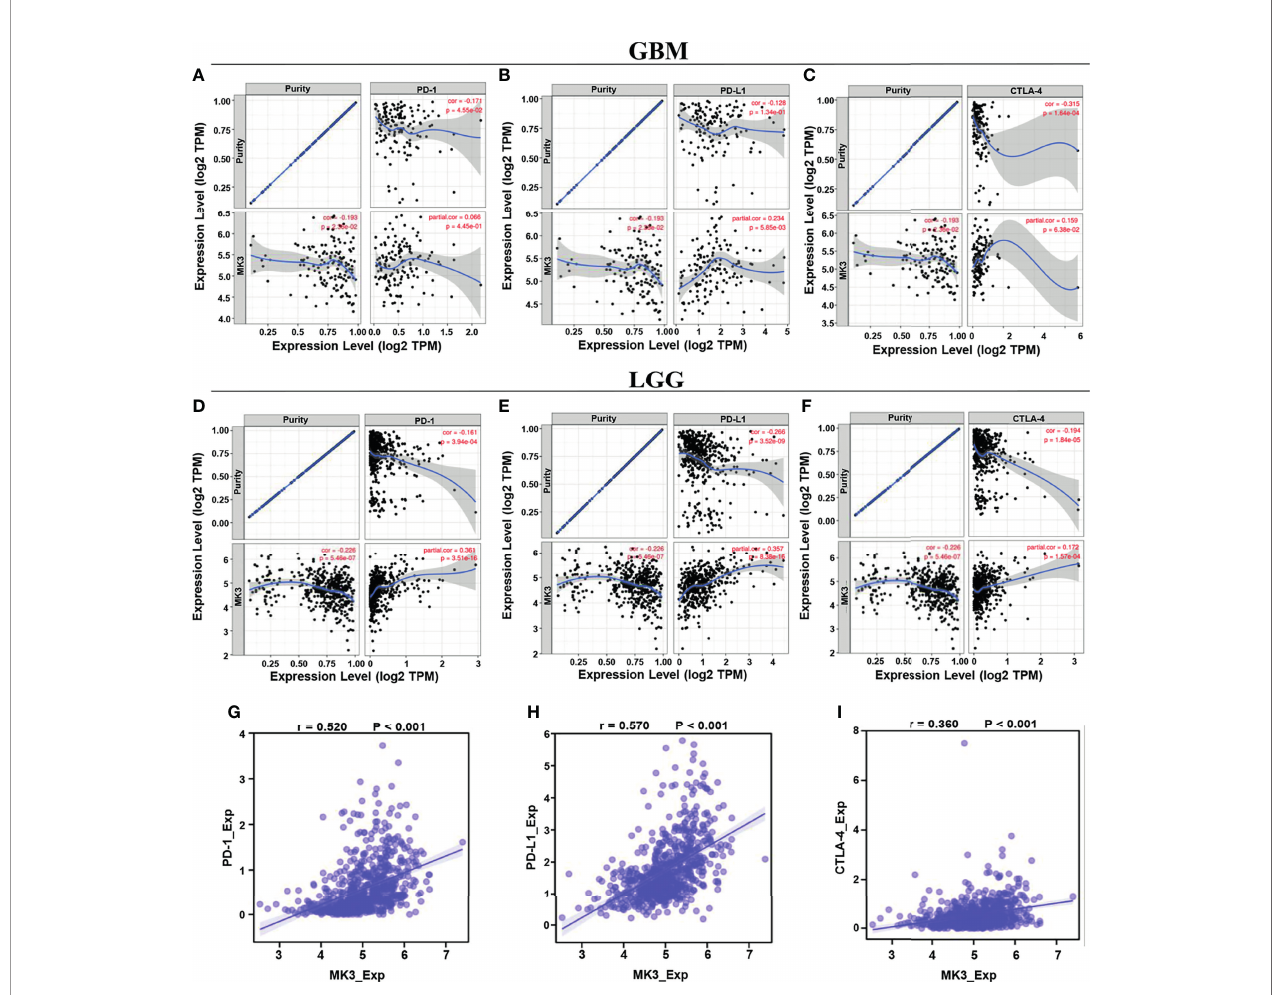
FIGURE 8 | Correlation of MK3 expression with PD-1 , PD-L1 , and CTLA-4 in glioma. (A – C) Correlation of MK3 expression with PD-1 (A) , PD-L1 (B) , and CTLA-4 (C) in GBM adjusted by tumor purity using TIMER. (D – F) Correlation of MK3 expression with PD-1 (D) , PD-L1 (E) , and CTLA-4 (F) in LGG adjusted by tumor purity using TIMER. (G – I) The expression correlation of MK3 with PD-1 (G) , PD-L1 (H) , and CTLA-4 (I) in GBM and LGG samples from TCGA dataset. GBM, glioblastoma; TIMER, Tumor IMmune Estimation Resource; LGG, low-grade glioma; TCGA, The Cancer Genome